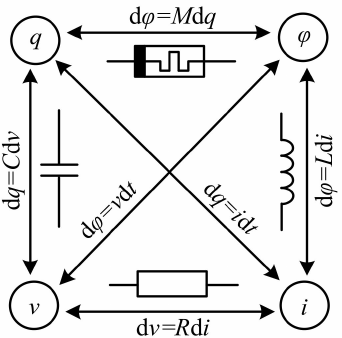
Figure 1. The relationship of four basic